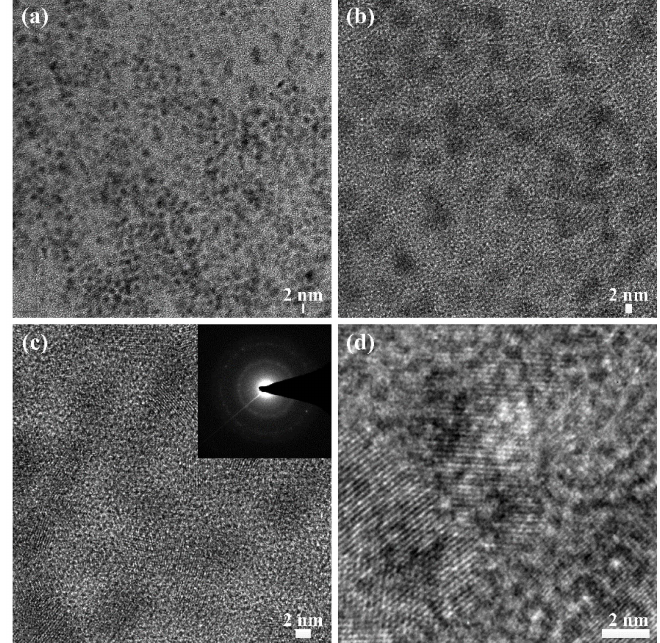
Figure 5. Transmission electron microscopy (TEM) images of pPANI nanoparticles thin film prepared via iPC-APPJ. ( a – d ) The different magnifications; the inset in (c) is the selected area electron diffraction (SAED) pattern of pPANI nanoparticles. Scale bar = 2 nm.